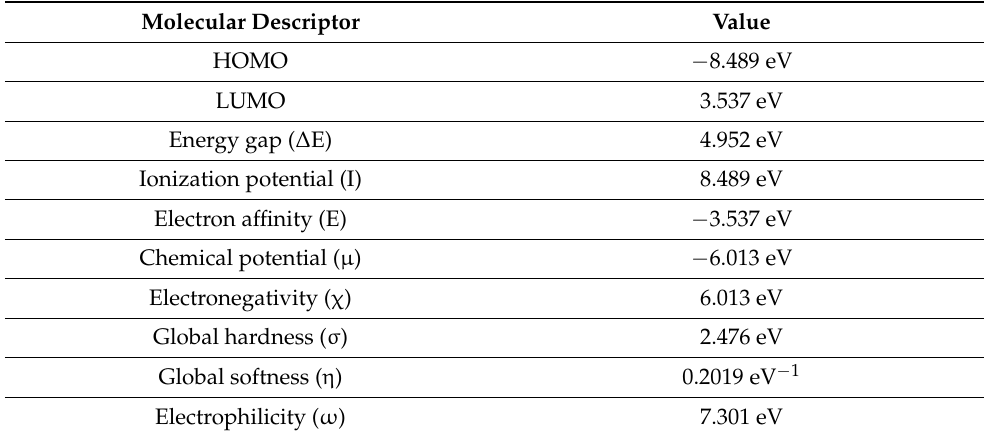
Figure 9. Energy levels of the frontier molecular orbital of the title molecule. Table 4. Calculated energy values of molecular descriptors of the title compound.